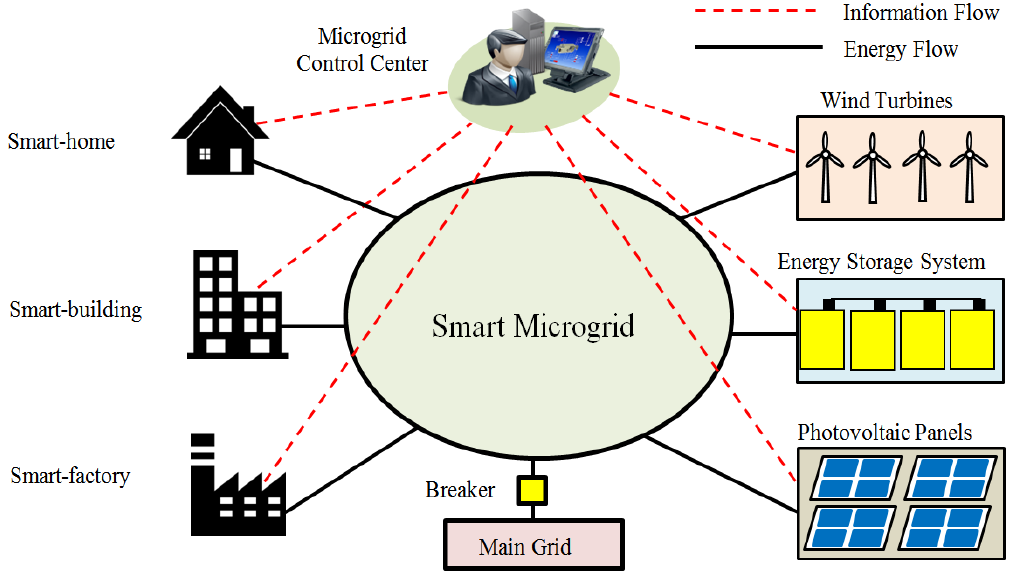
Figure 1. Overview of a microgrid system with renewable energy resources (e.g., small-scale WTs and PV